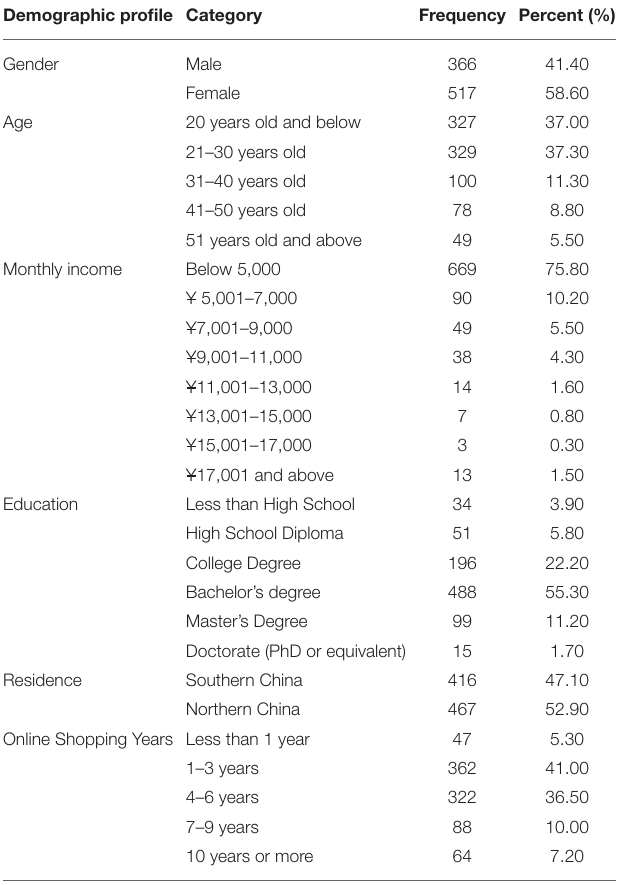
TABLE 1 | Respondent profile ( N =